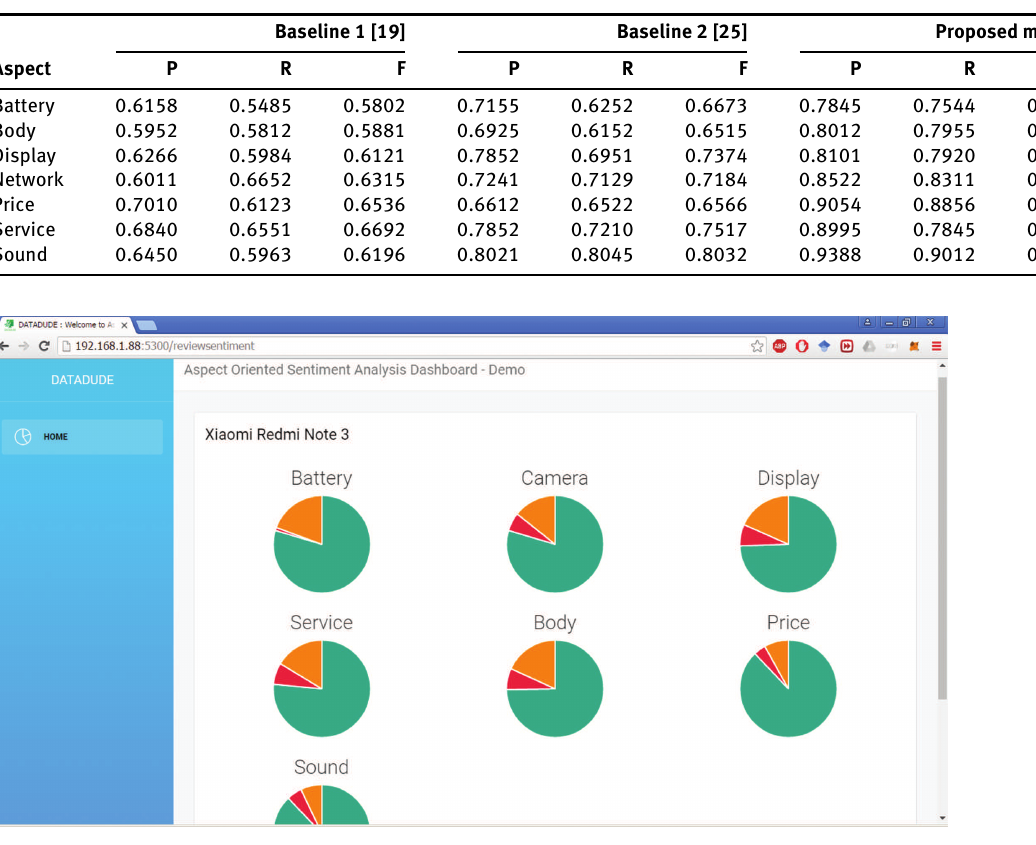
Figure 7: Screenshot of Web Application Developed for Finding Aspect-Oriented Sentiment of Customers for Mobile Phones and Accessories Using Proposed